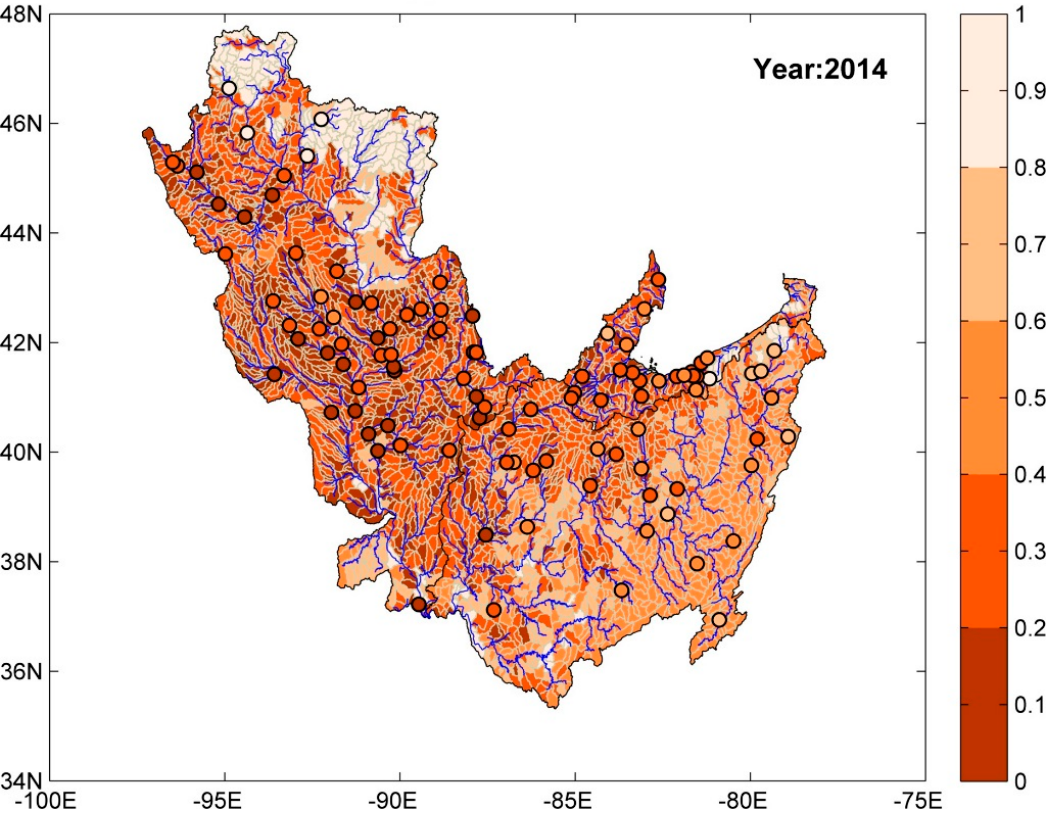
Figure 4. Prediction of watershed health (with respect to SSC) at ungauged HUC-10 basins for the year 2014 using random forest regression model. Circular markers denote the location of USGS- NAWQA stations where SSC measurements were available and are color-coded based on watershed health for year 2014.